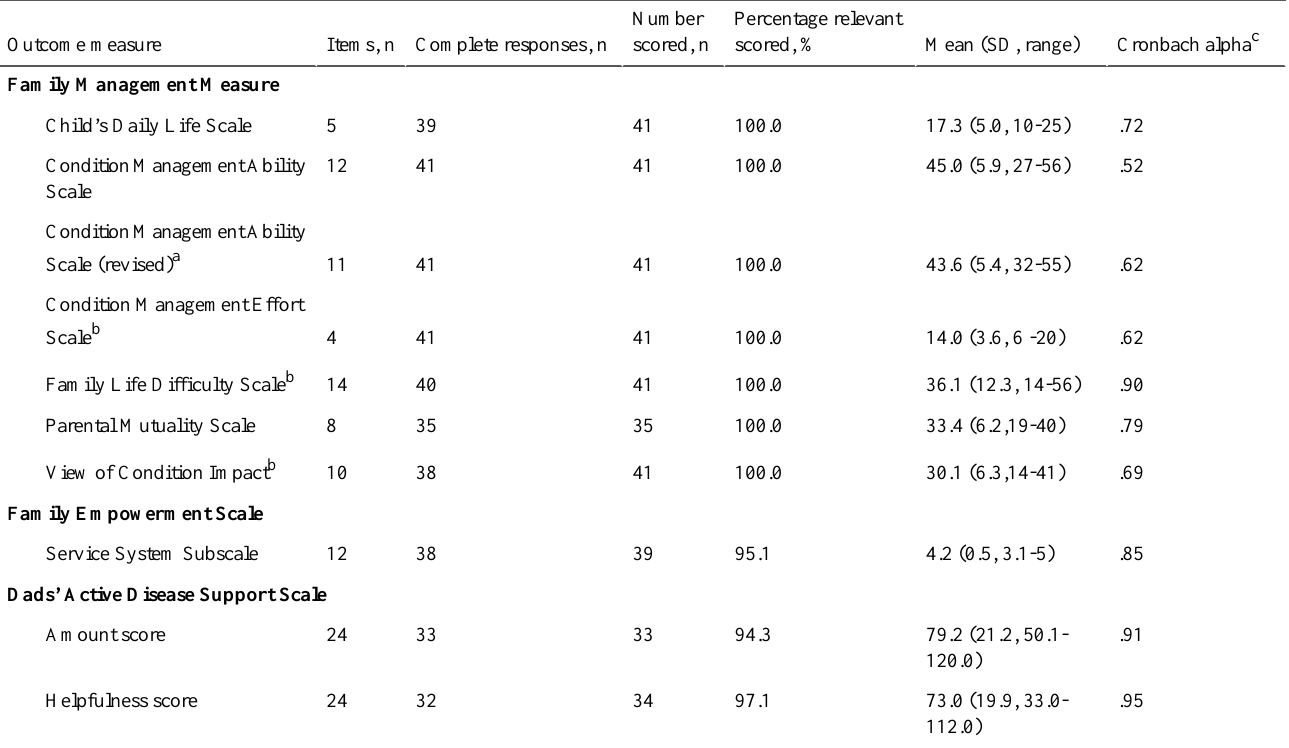
Table 3. Descriptive statistics and reliability estimates for the study outcome measures at baseline across total sample for parents completing the